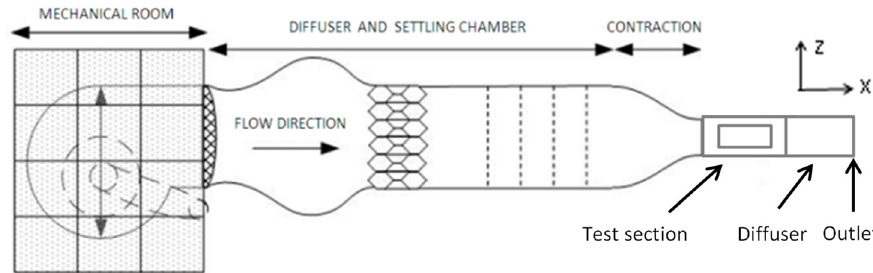
Figure 2. The wind tunnel sections with coordinates.